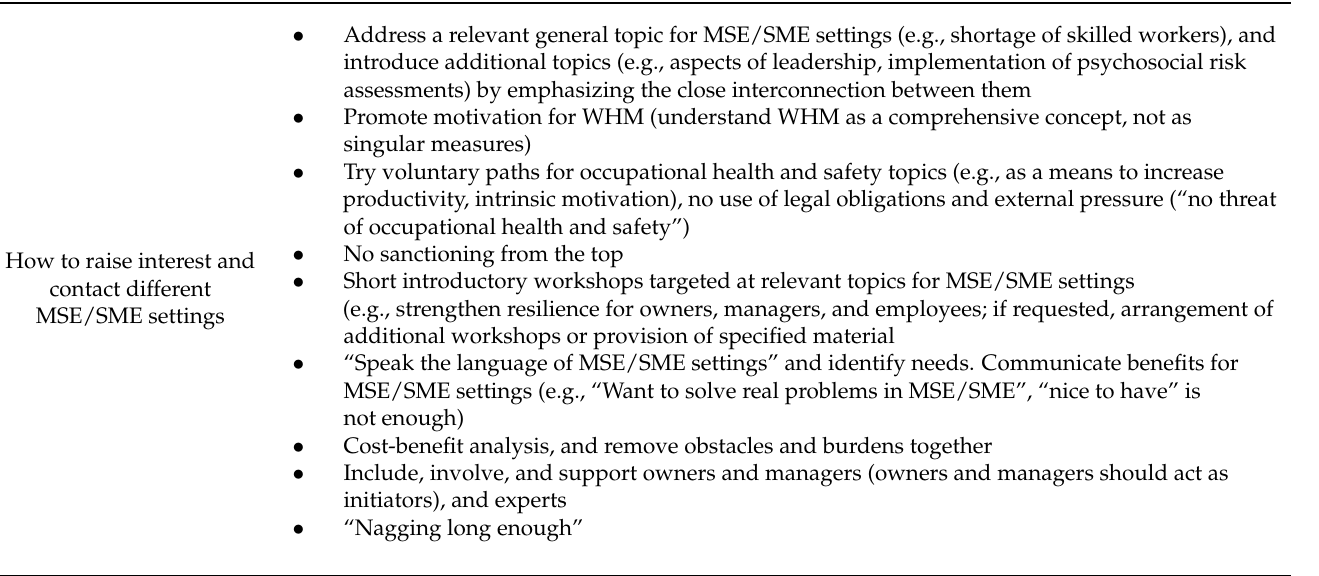
Table 3. Facilitators for the transfer of the topics of the IMPROVE job intervention into other MSE/SME